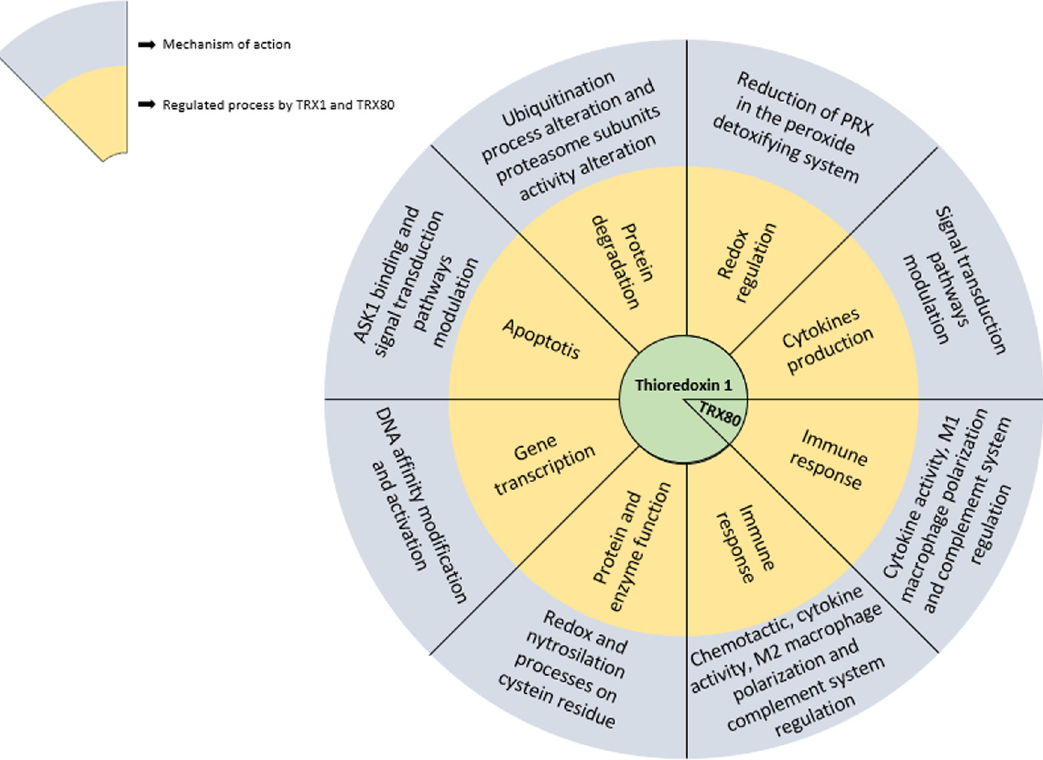
Figure 5: Participation of TRXs in di ff erent cell processes, diseases, and possible applications. Due to their redox properties, transnitro - sylation ability, chemotactic e ff ects, or their cytokine functions, TRXs participate in a wide and varied number of cell processes. This fi